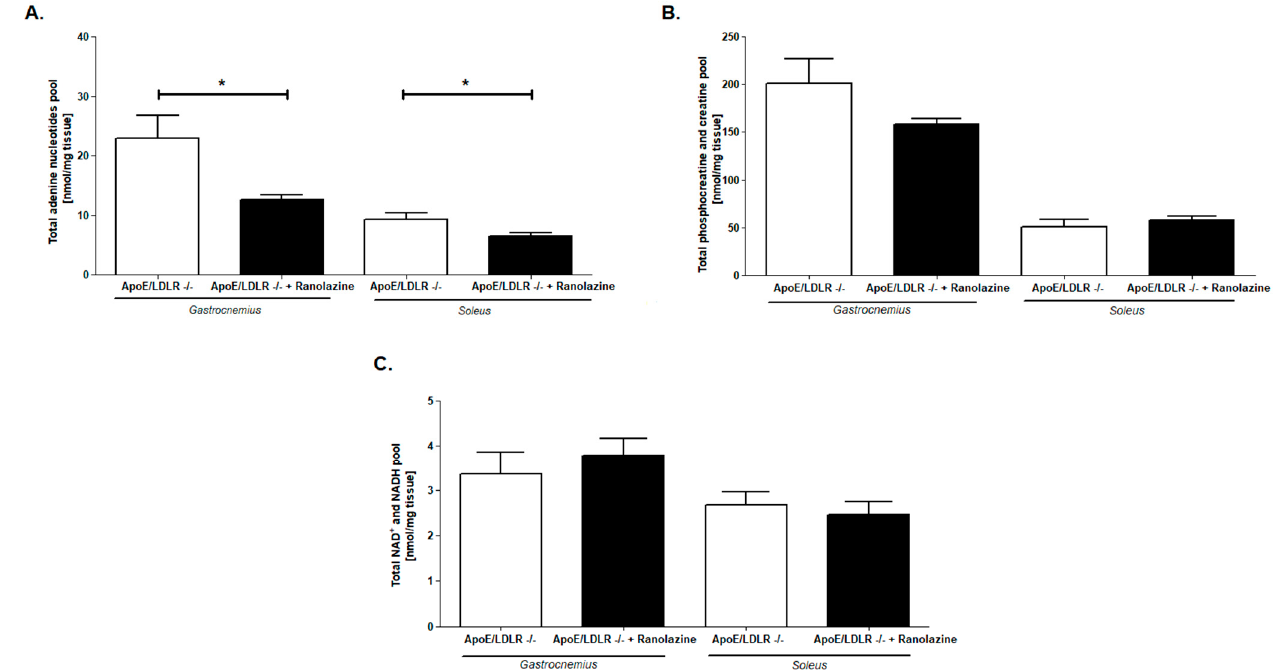
Figure 9. Enhanced total adenine nucleotides pool in skeletal muscles of ApoE/LDLR -/- mice was suppressed by Ranolazine (inhibitor of free fatty acids oxidation). Total adenine nucleotides ( A ), phosphocreatine and creatine ( B ), and NAD+ and NADH ( C ) pools in gastrocnemius and soleus of ApoE/LDLR -/-, and ApoE/LDLR -/- Ranolazine treated mice. Results presented as mean ± SEM, n = 6–8, * p < 0.05.